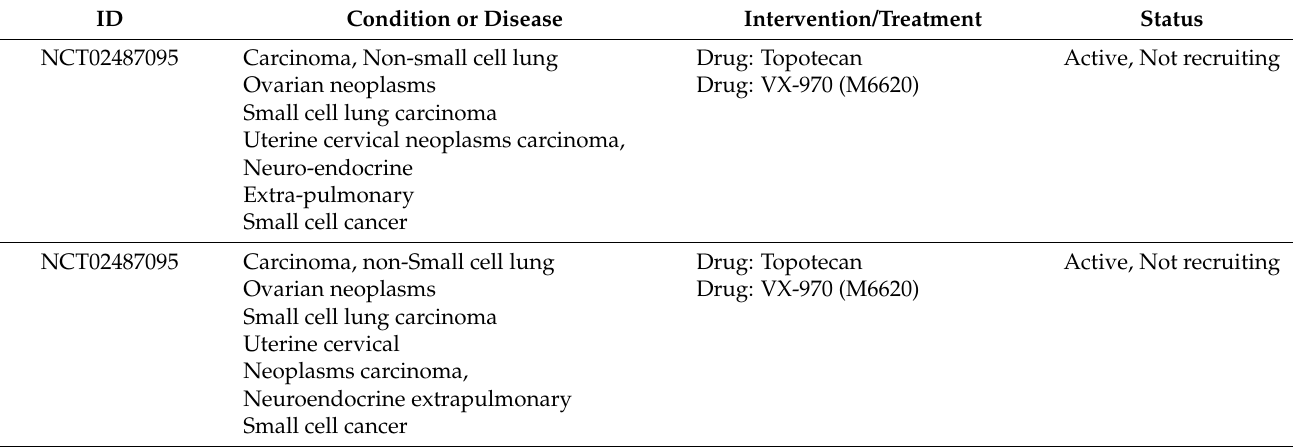
Table 1. The current clinical trials of ATM/ATR inhibitors as monotherapies or in combination with other chemotherapeutic drugs for the treatment of SCLS and